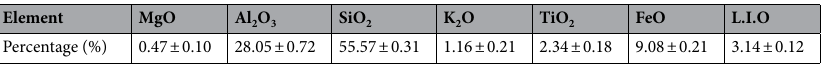
Table 1. The chemical compositions of red clay.